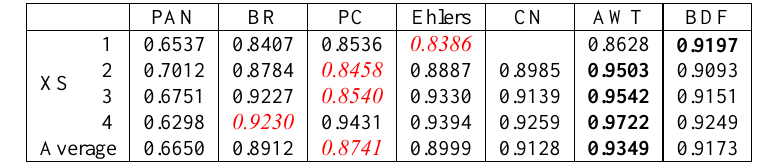
Table 10. CC between QuickBird multispectral and fused images using different algorithms BR PC Ehlers CN AWT BDF